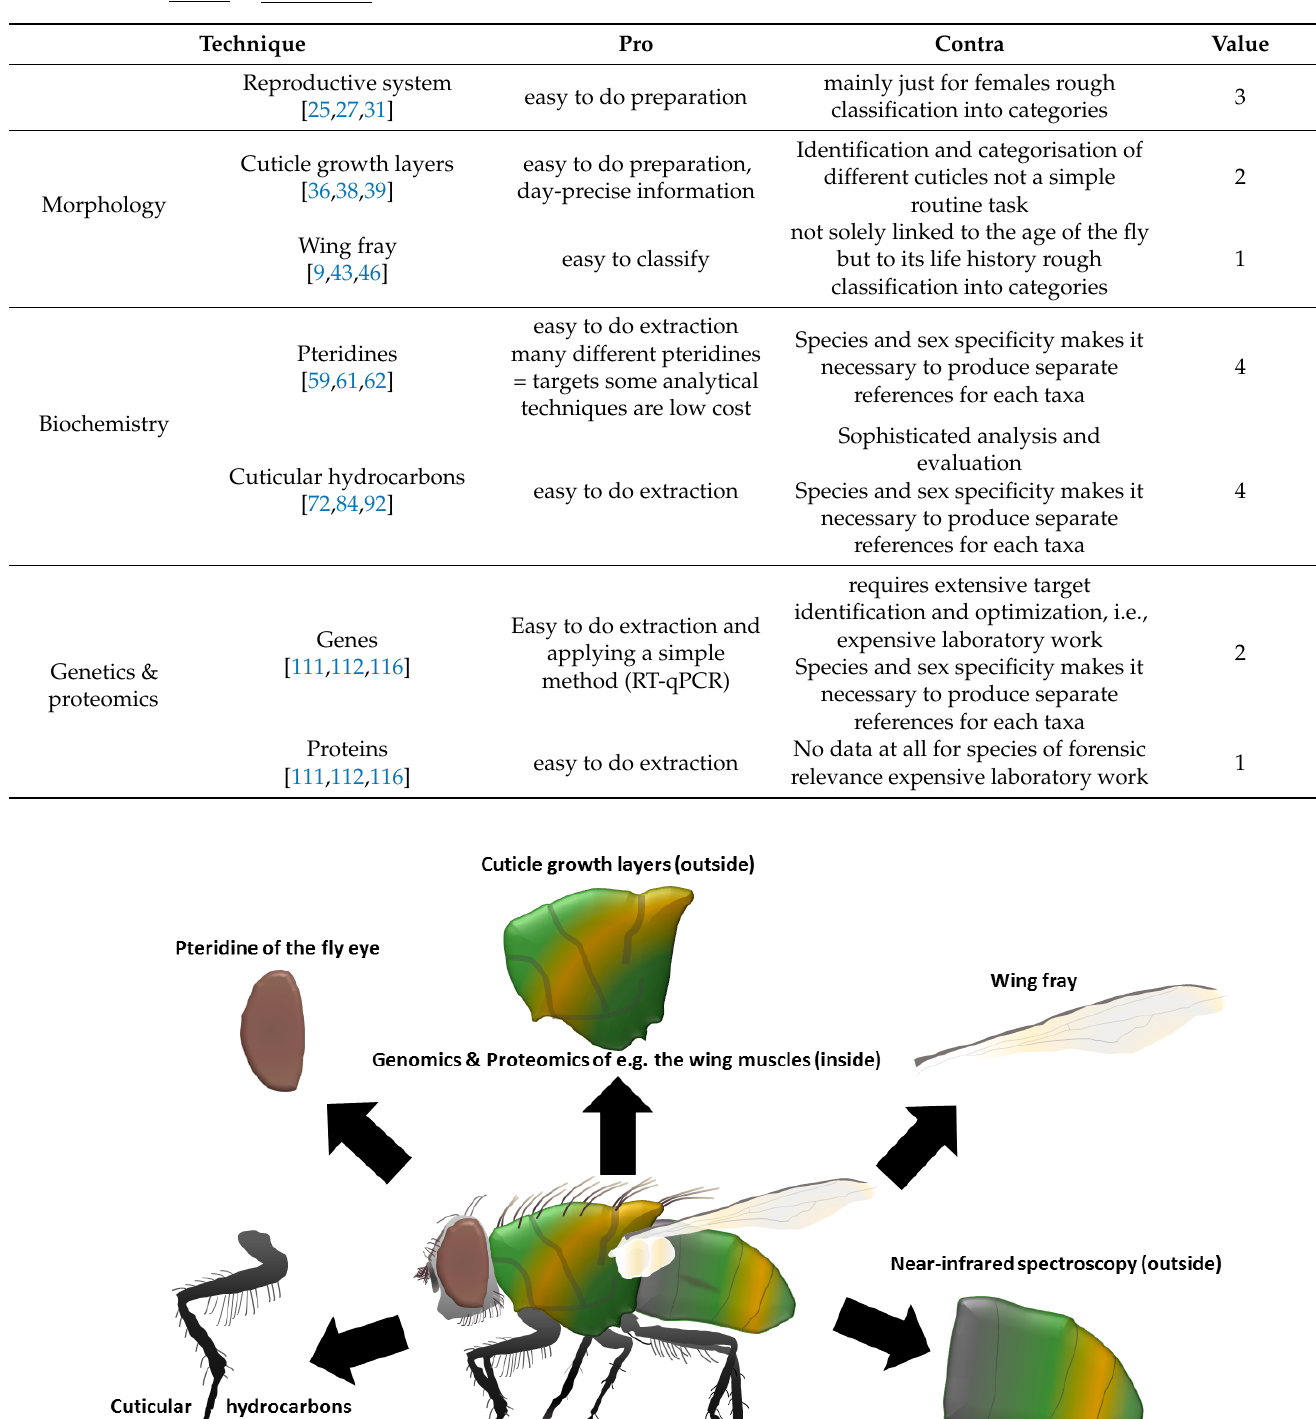
Table 1. Summary of existing methods [in brackets key references] and an assessment of their current value/benefit with a scale from 1: bad to 5: excellent.